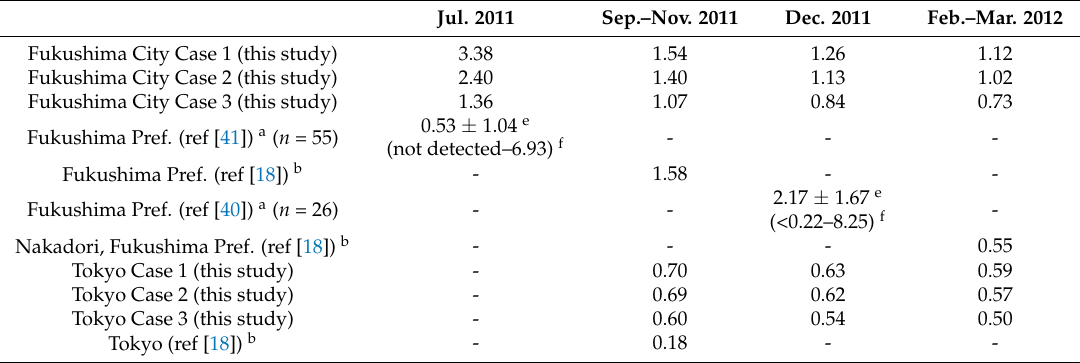
Table 1. Estimated and observed effective doses for men ( ≥ 19 y) [ µ Sv month − 1 ]: (a) Fukushima City (or Fukushima Pref.), (b) Tokyo (or Kanto), and (c) Osaka. Observed values are taken from food-duplicate and market-basket surveys [18,40,41]. Case 1, the distribution of foods was restricted if the estimated median concentrations of radionuclides exceed regulation values. Case 2, median > 1/2 × regulation values. Case 3, median > 1/5 × regulation